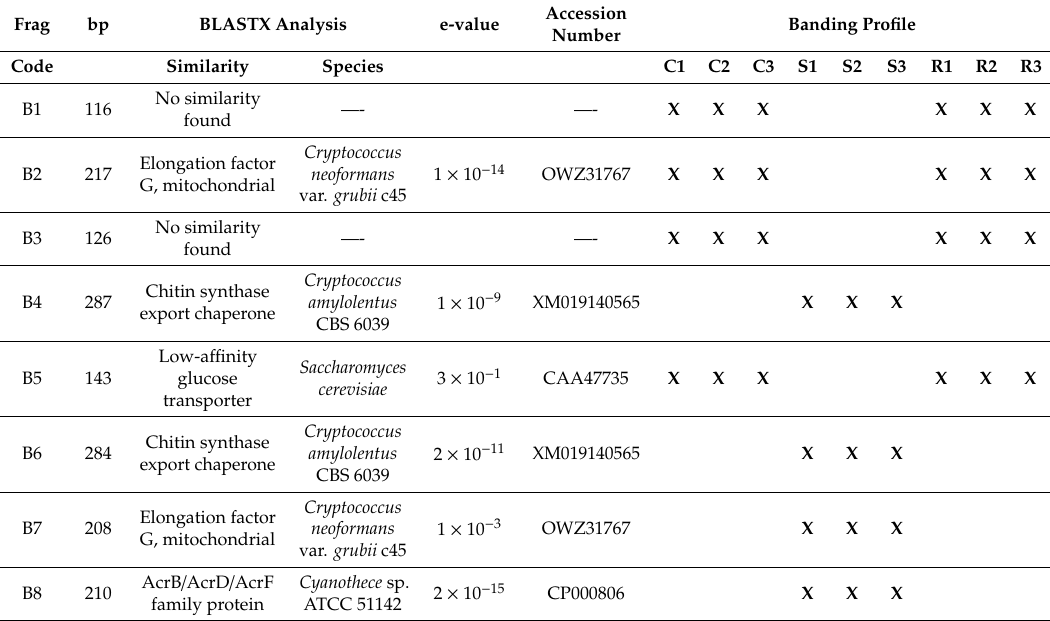
Table 4. Functional association of the methylated fragments. X = presence of amplification product. The complete scoring of samples is given in Table